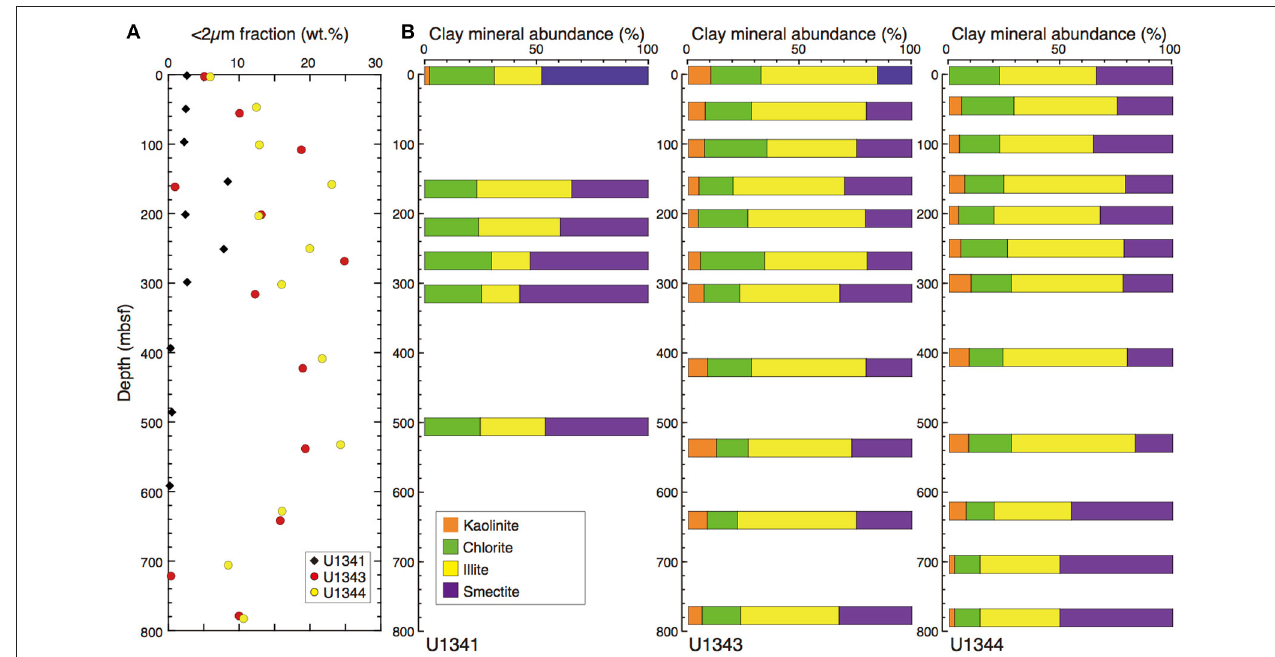
FIGURE 8 | Clay-size fraction ( < 2 µ m) and clay mineral composition at Sites U1341, U1343, and U1344. (A) Vertical profile of the clay-size fraction ( < 2 µ m) in the bulk sediment. (B) Relative percentages of smectite, illite, chlorite, and kaolinite.